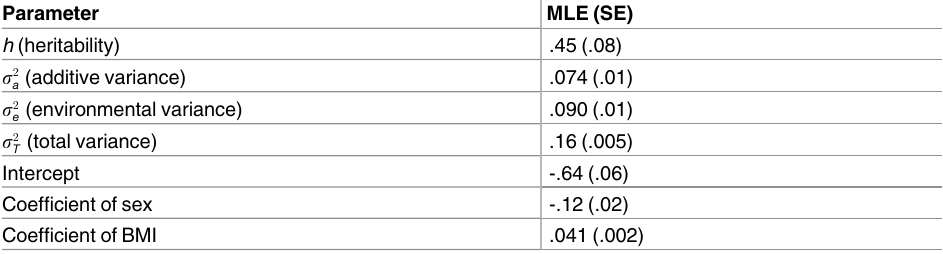
There are only 2 independently specified VC parameters in the model; the 4 VC parameters in the table are